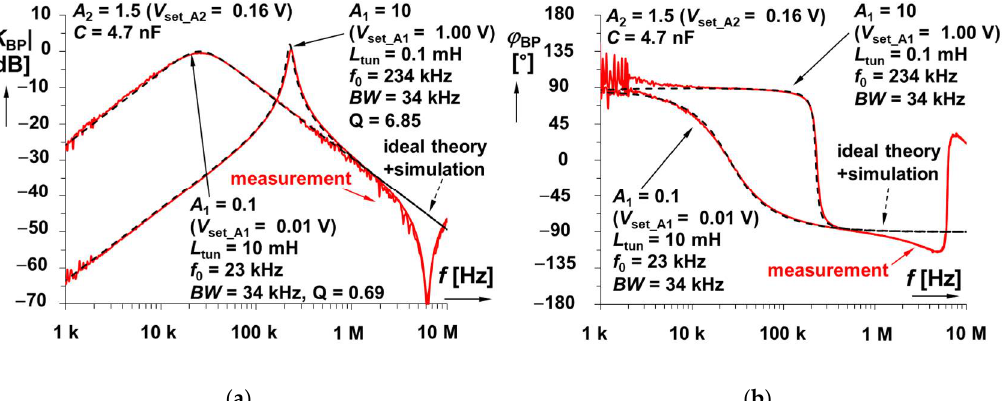
Figure 12. Frequency responses of electronically tunable BP LC filter: ( a ) magnitude responses and ( b ) phase responses.